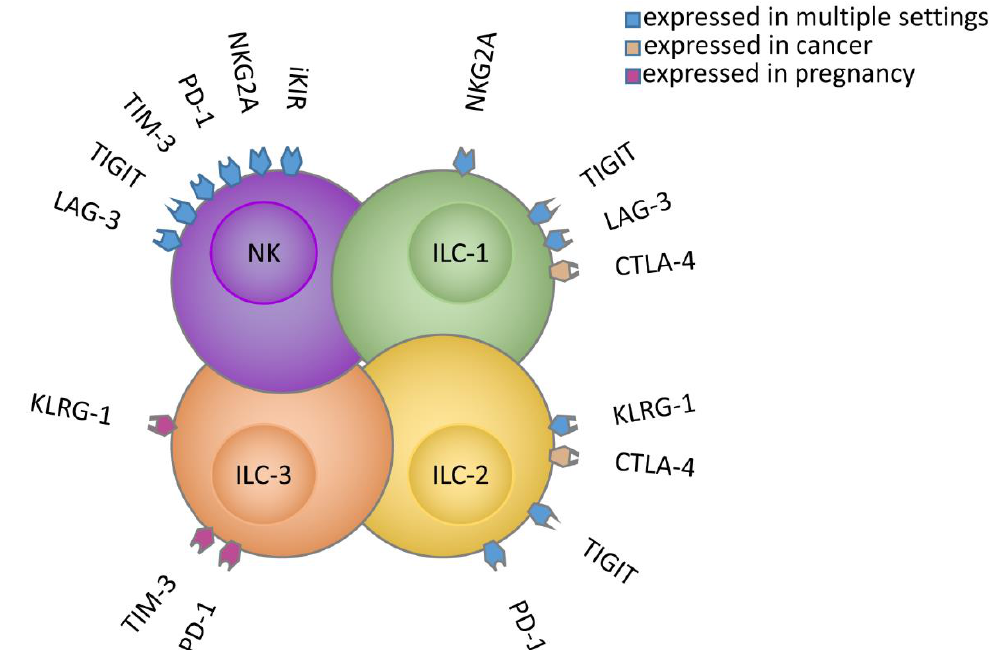
Figure 1. IC expression on NK cells/ILCs in healthy and pathological conditions.